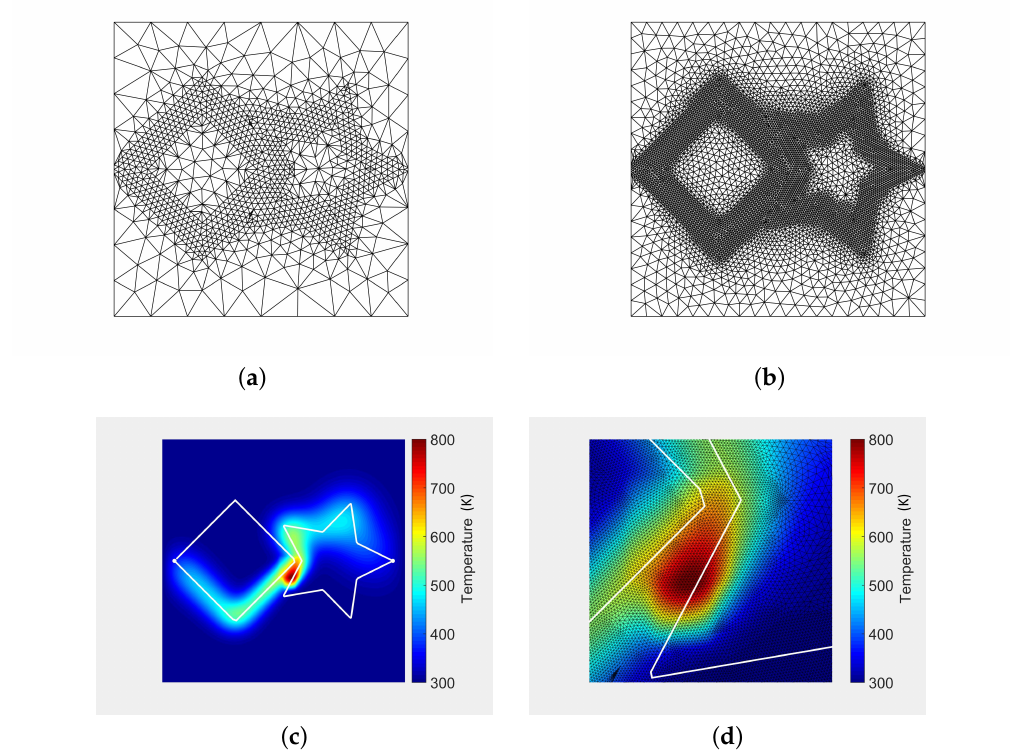
Figure 4. ANSYS R (cid:13) FEA simulation results for the same test case presented in Figure 3. ( a ) coarse FEA mesh (2.1 k triangles); ( b ) intermediate mesh refinement at laser trajectory (13 k triangles); ( c ) t = 0.094 s. FEA temperature; ( d ) 10 x zoom on Figure 4c.